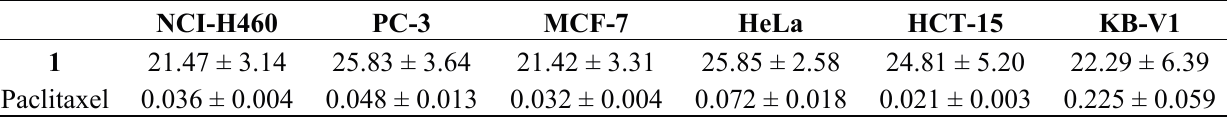
Table 2. IC 50 values ( μ M) of 1 in six human cancer cell lines at 48 h. Cancer cells were treated with Cajanstilbene H ( 1 ) or paclitaxel (positive control) for 48 h. Cell viability was measured by MTT assay. Data were expressed as Mean ± SD of three independent